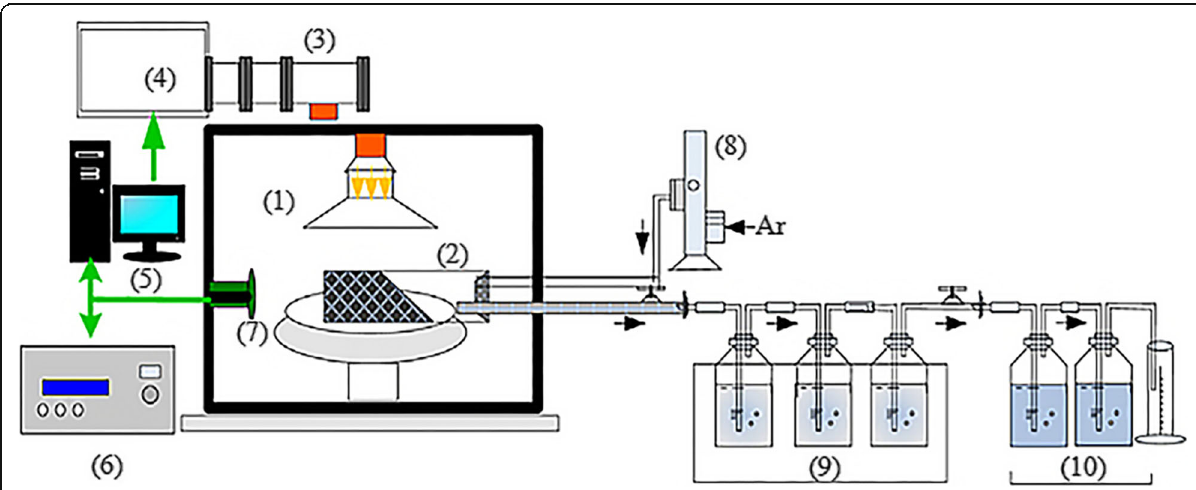
Fig. 2 A schematic of the microwave preparation reactor assembly [12]. (1) microwave cavity; (2) quartz reactor; (3) waveguide; (4) magnetron; (5) PC with fuzzy logic algorithm; (6) power governor; (7) infrared radiation thermometer; (8) gas flowmeter; (9) tar products collection unit; (10) gas products collection